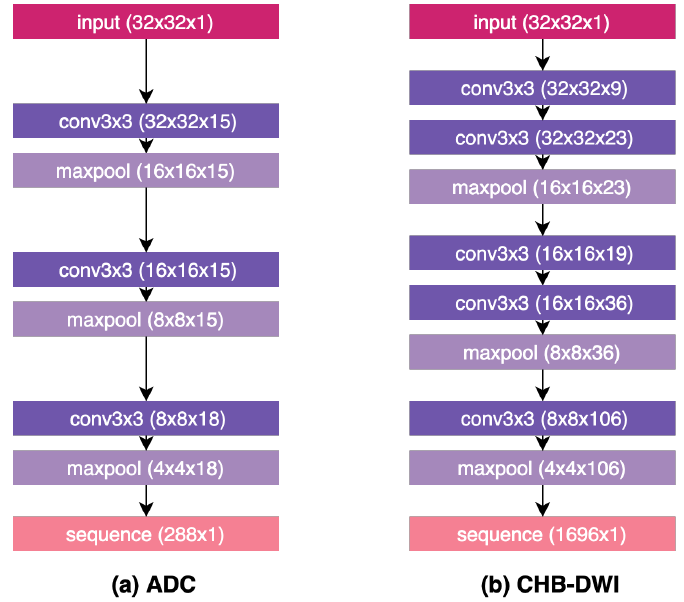
Figure 4. Radiomic sequencer designs discovered via a machine-driven radiomic sequencer design strategy for ( a ) ADC sensing modality and ( b ) CHB-DWI sensing